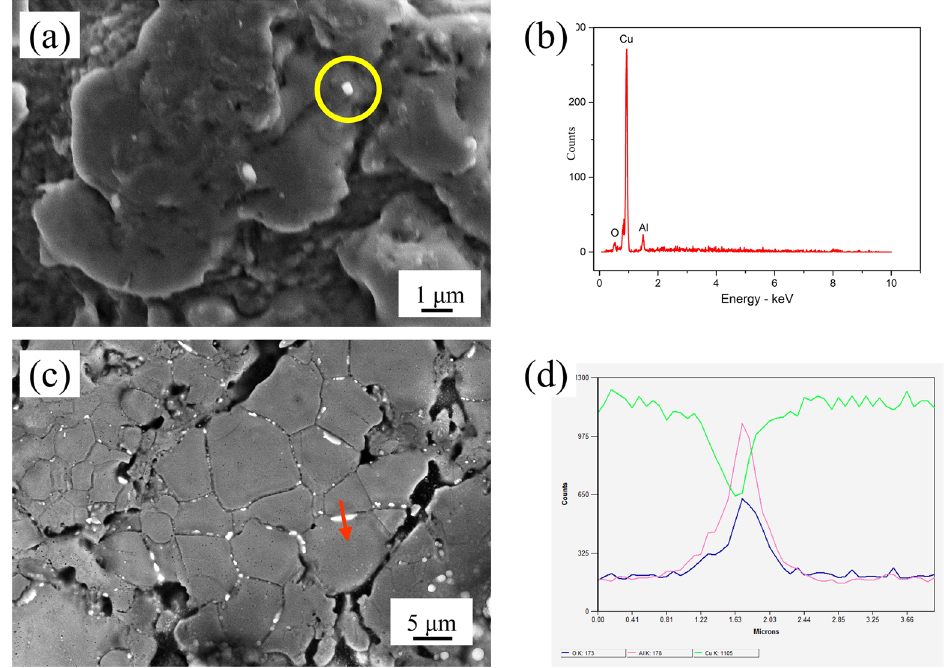
Figure 3: ( a ) SEM image of the ODS Cu powder surface, ( b ) the EDS of white spot shown in ( a ) , ( c ) cross - section of ODS powder, and ( d ) EDS scan over the powder boundaries in ( c ) .